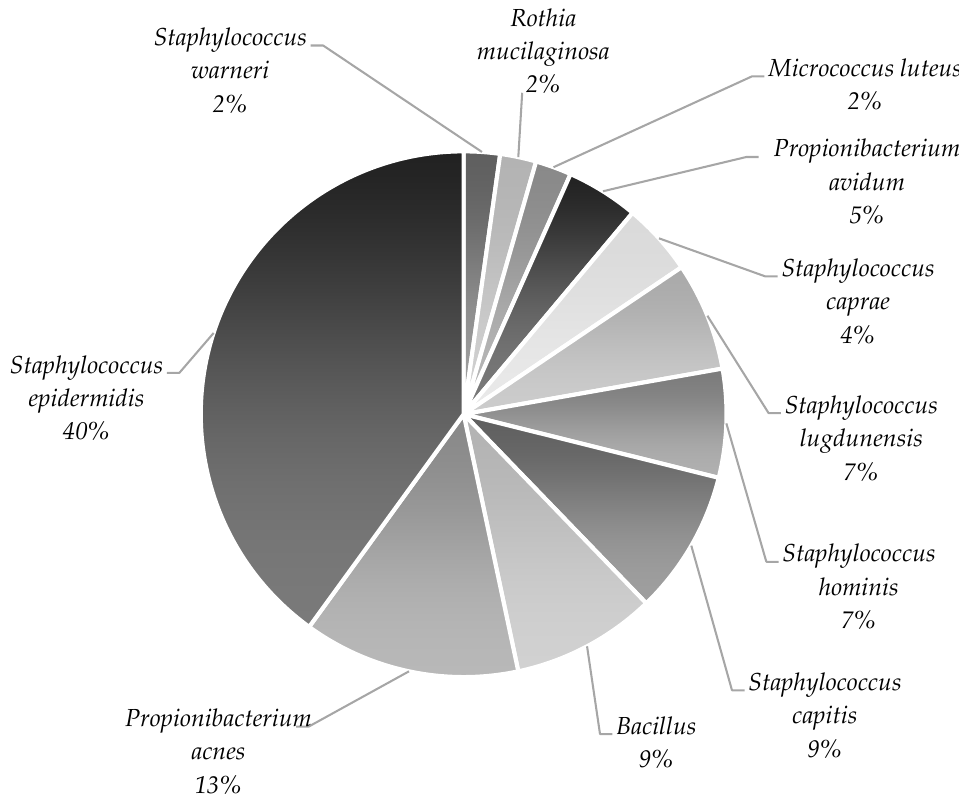
Figure 2. Microbiota identified in lipoaspirates collected throughout the clinical trial are presented as the % of each genus out of all the identified microorganisms. All isolated bacteria of the Bacillus genus are presented together.